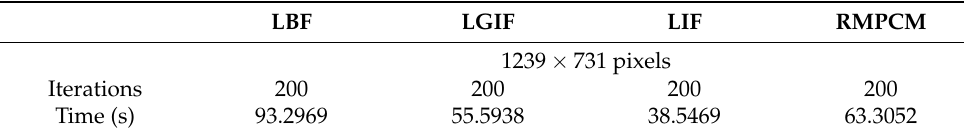
Table 1. Iterations and CPU time (in seconds).